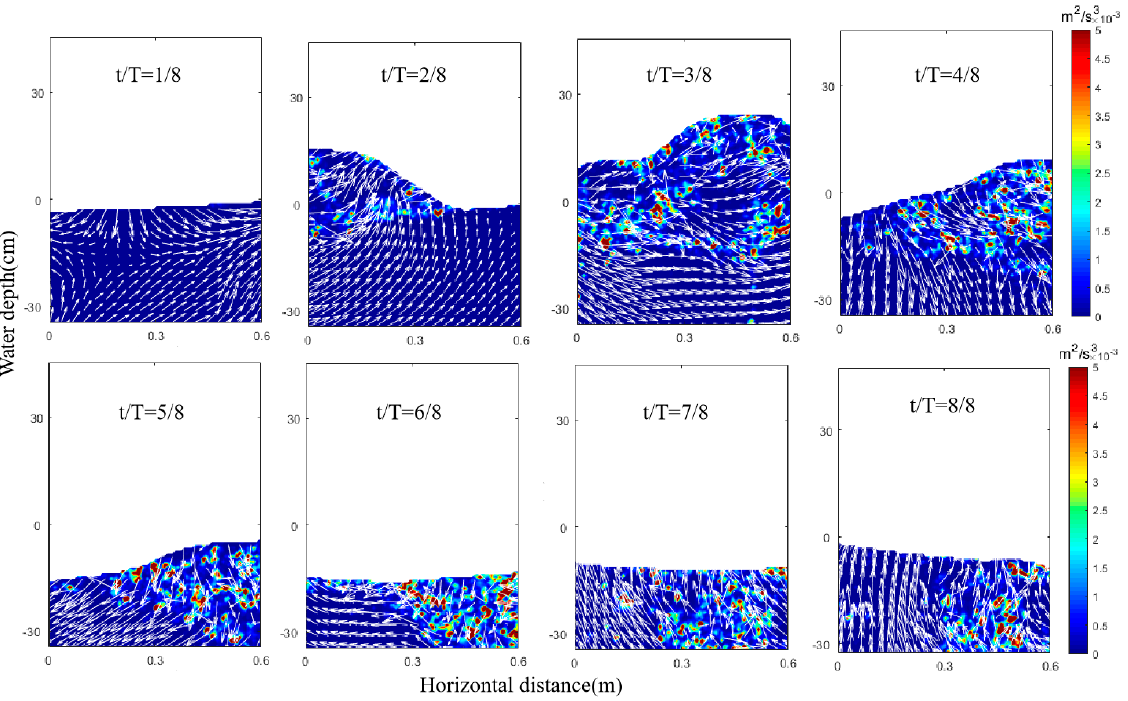
Figure 17. Spatial distribution of turbulent dissipation rate for 25 cm breaking wave.